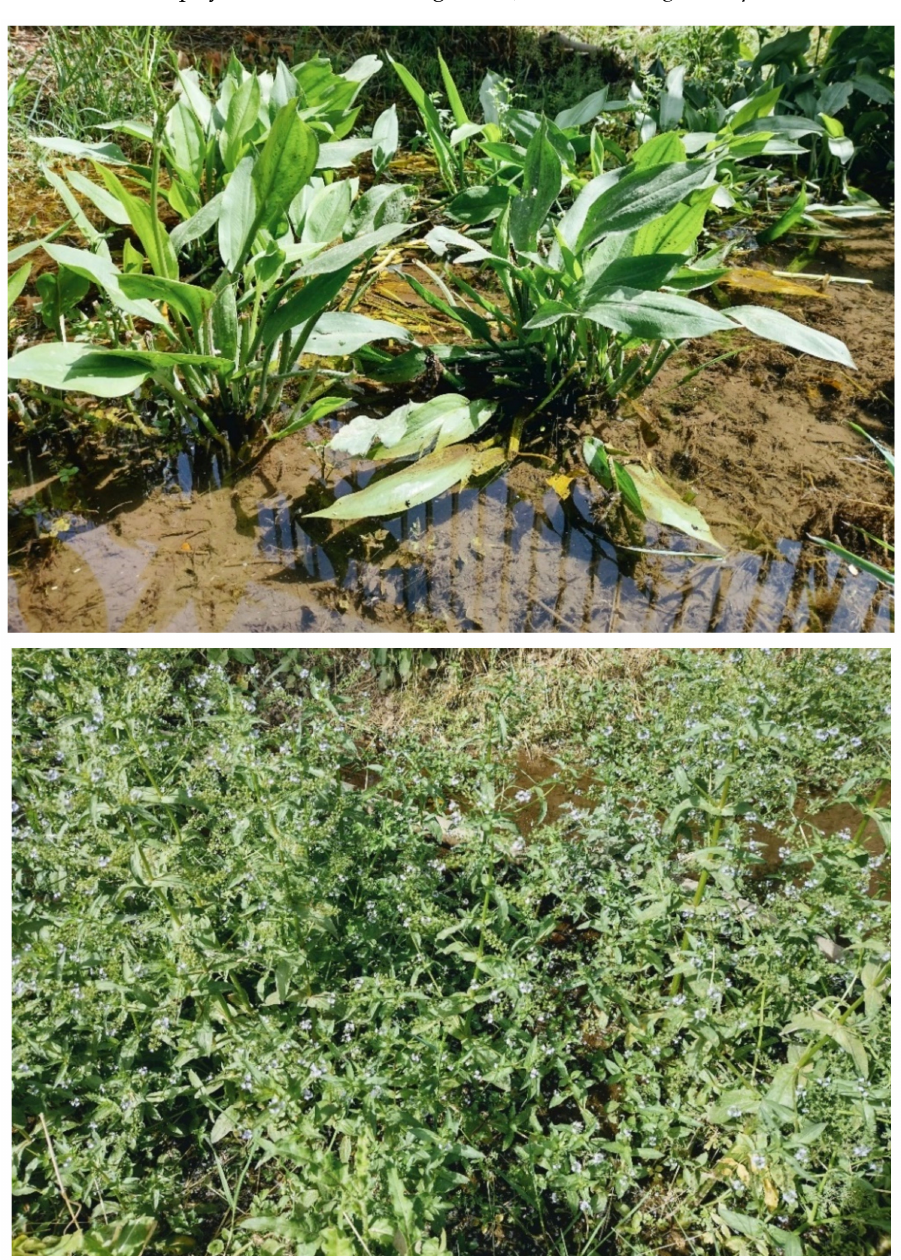
Figure 26. Phragmito-Magnocaricetea on channel Acqua Mariana (Acquedotti locality) with Alisma planta-go-aquatica (top photo) and Veronica anagallis-aquatica dominated (bottom